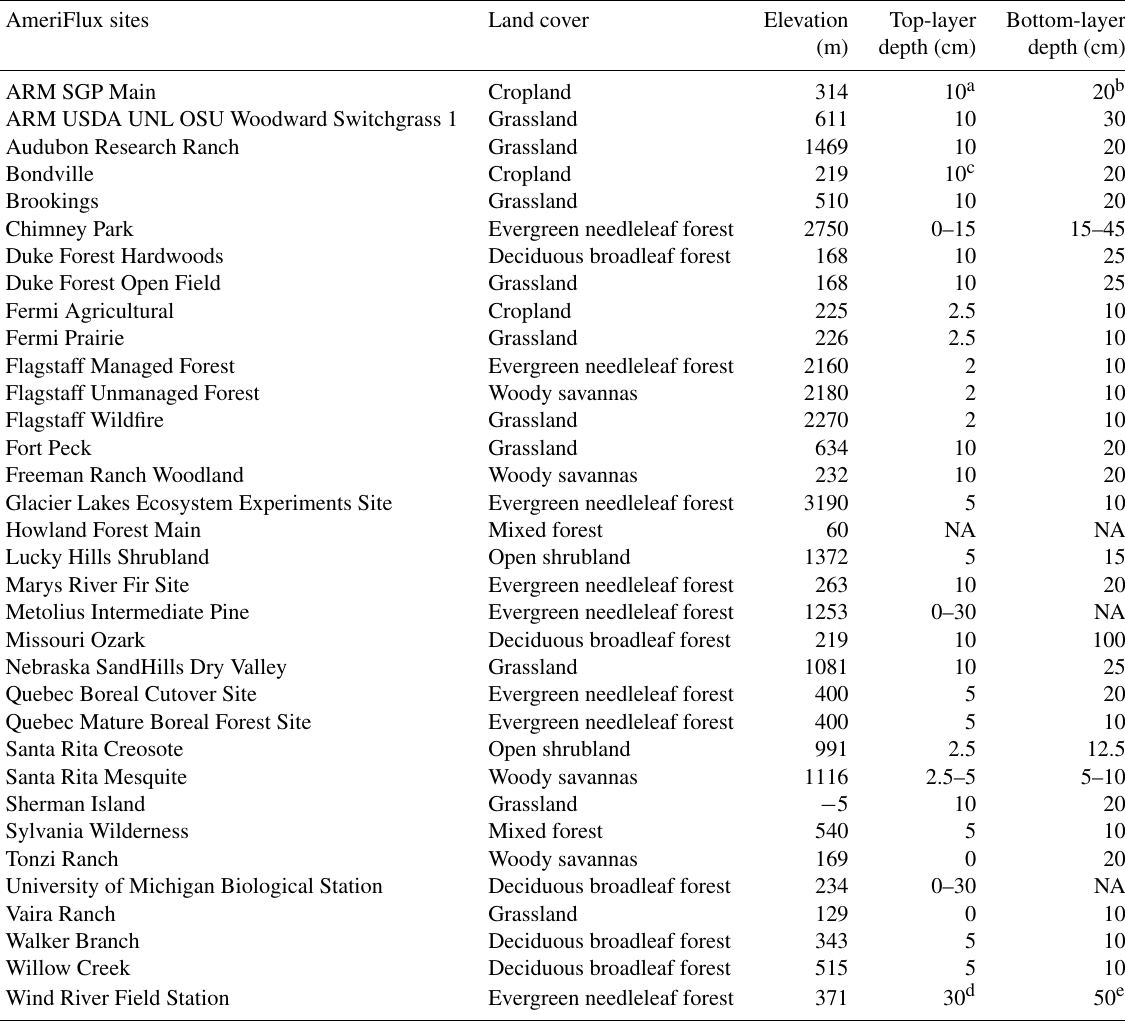
Table 1. Attributes of selected AmeriFlux sites. AmeriFlux sites